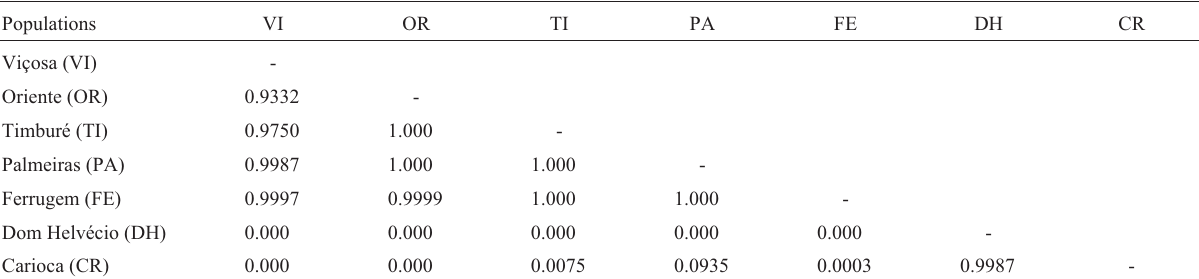
Table II - Fisher’s Exact Test (50 repetitions, 1000 permutations) of RAPD allele heterogeneity of seven populations of Hoplias malabaricus in the Rio Doce basin. Non-significant values of CR and PA may be an artifact of small PA sample